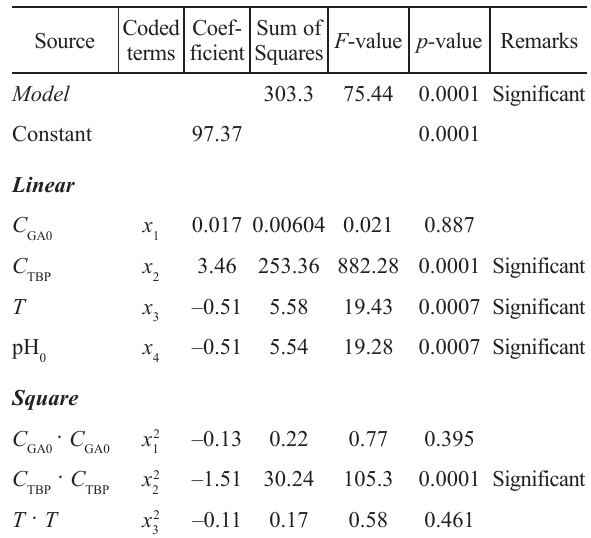
Table 3 – Analysis of variance (ANOVA) for the experimen- tal results of the rotatable orthogonal central com- posite